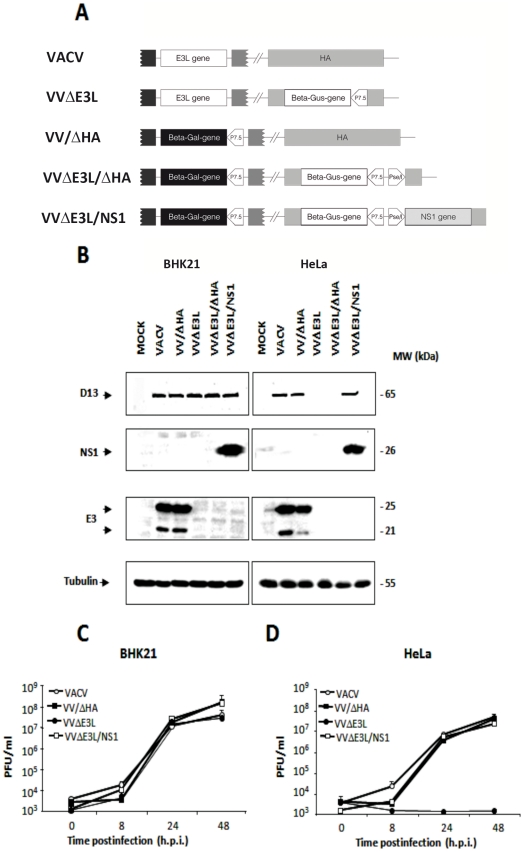
Generation, characterization, and growth properties of VACV recombinants.
A. Schematic representation of the VACV recombinants used for this study. The mutant virus VVΔE3L was generated by replacing the VACV E3L gene by the β-galactosidase (beta-gal) marker gene [37]. The influenza A (Puerto Rico/8/34) virus NS1 gene was introduced into the HA coding region (A56R gene) of VVΔE3L virus together with the E. coli β-glucuronidase (beta-gus) marker gene to allow the selection of the VVΔE3L/NS1 recombinant virus. Control viruses VV/ΔHA and VVΔE3L/ΔHA were generated by introducing the β-glucuronidase gene into the HA locus of VACV and VVΔE3L genomes, respectively. The VACV P7.5 and Pse/l promoters are indicated. B. Analysis of E3 and NS1 protein expression by recombinant viruses. Extracts from BHK21 (left panels) or HeLa (right panels) cells mock-infected (MOCK) or infected (MOI 5) for 24 h with VACV, VV/ΔHA, VVΔE3L, VVΔE3L/ΔHA or VVΔE3L/NS1 were separated by SDS-PAGE. Proteins transferred to nitrocellulose membranes were detected with antibodies against VACV E3 and influenza A virus NS1 proteins. E3L gene directs the synthesis of two proteins of 25 kDa and 20 kDa, of which the latter was previously suggested to be a product of internal initiation. As a control for viral infection an antibody against the VACV D13 protein was also used. Tubulin was detected as a protein loading control. C and D. Growth curves of mutant viruses in permissive BHK21 (C) or non-permissive HeLa cells (D). Infected cells (0.01 PFU/cell) were harvested at different times p.i. and virus yields were determined by plaque assay (VACV, VV/ΔHA, VVΔE3L/NS1) or by immunostaining (VVΔE3L). Results represent the mean ± the standard deviation of three independent experiments.